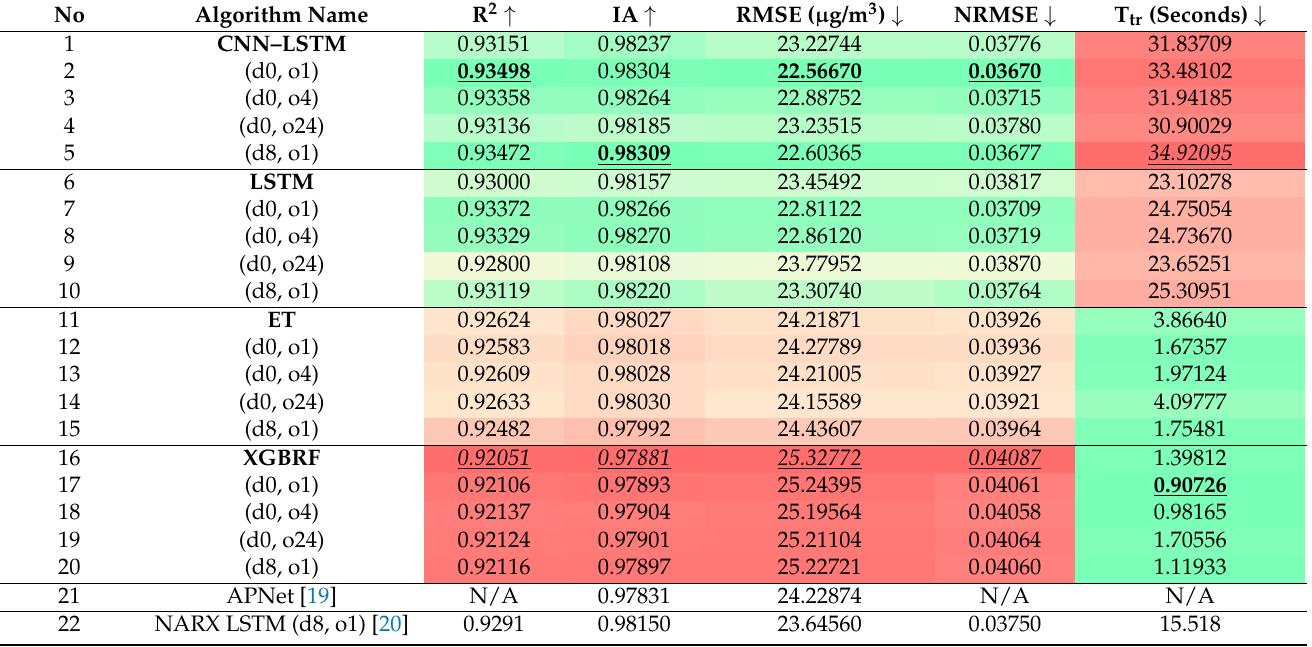
Table 5. Prediction evaluation metrics averaged for Timeseries K-Fold = 10 for the Beijing